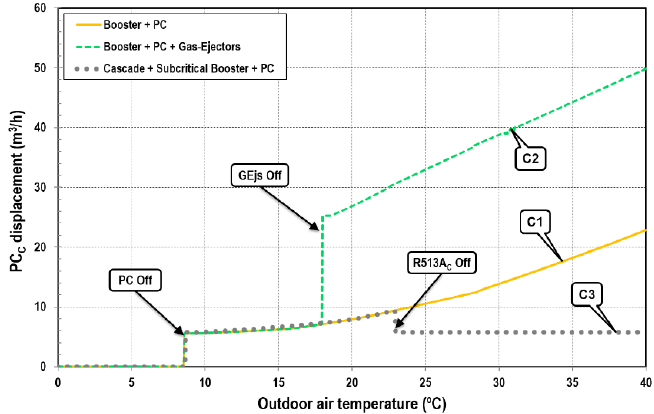
Figure 14. Parallel compressor displacement.